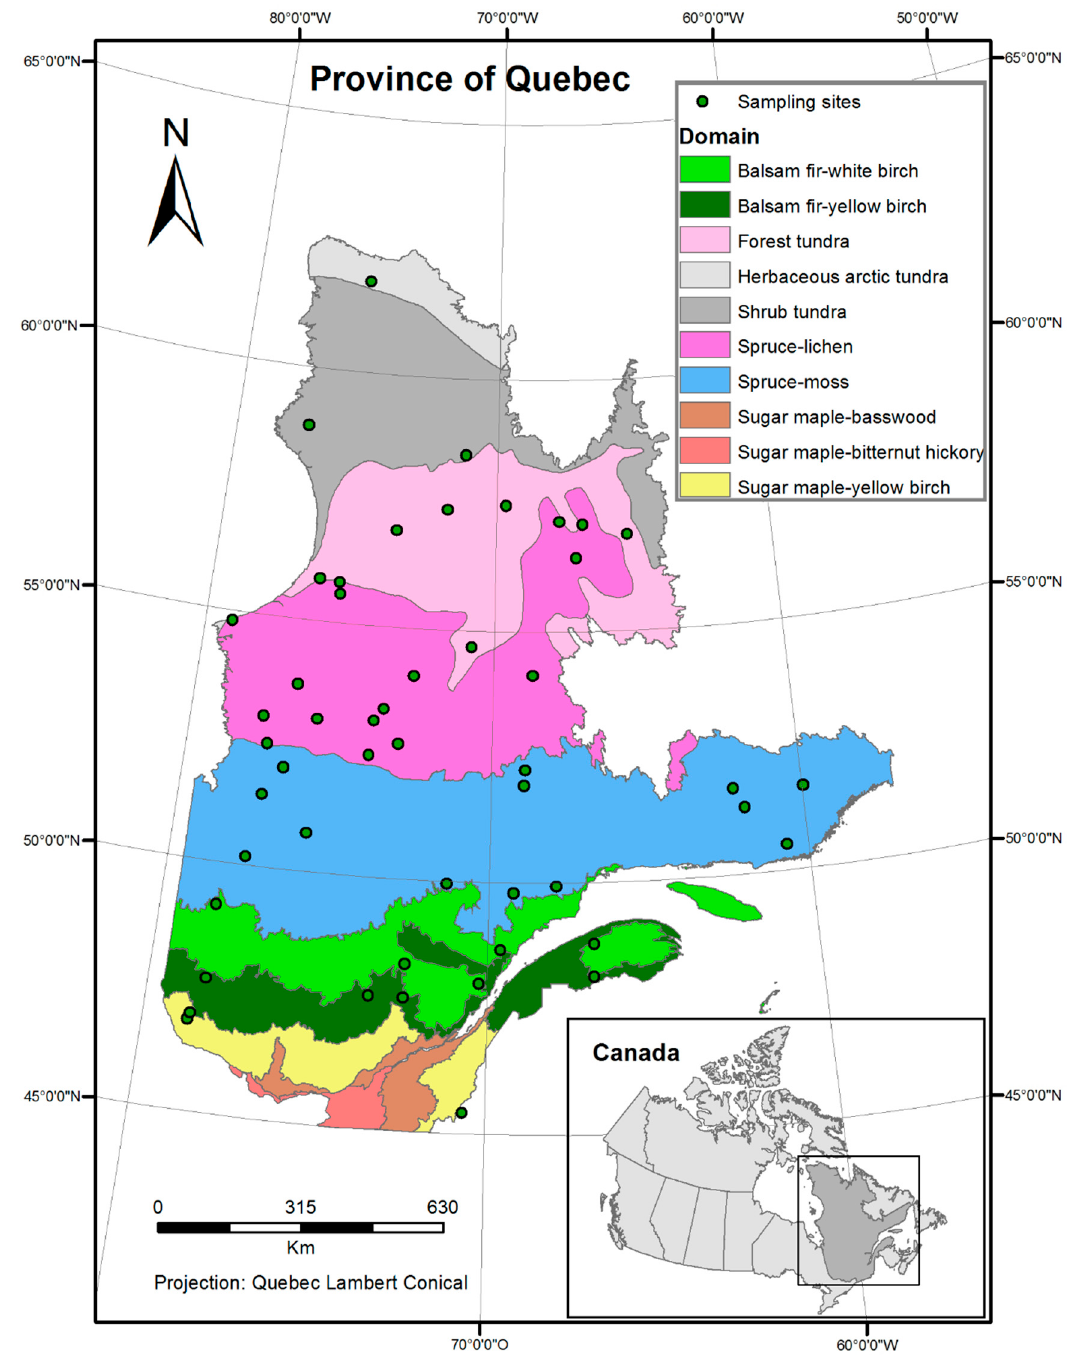
Figure 1. Map of bioclimatic domains found in the province of Quebec and sampled sites randomly selected for the analysis.